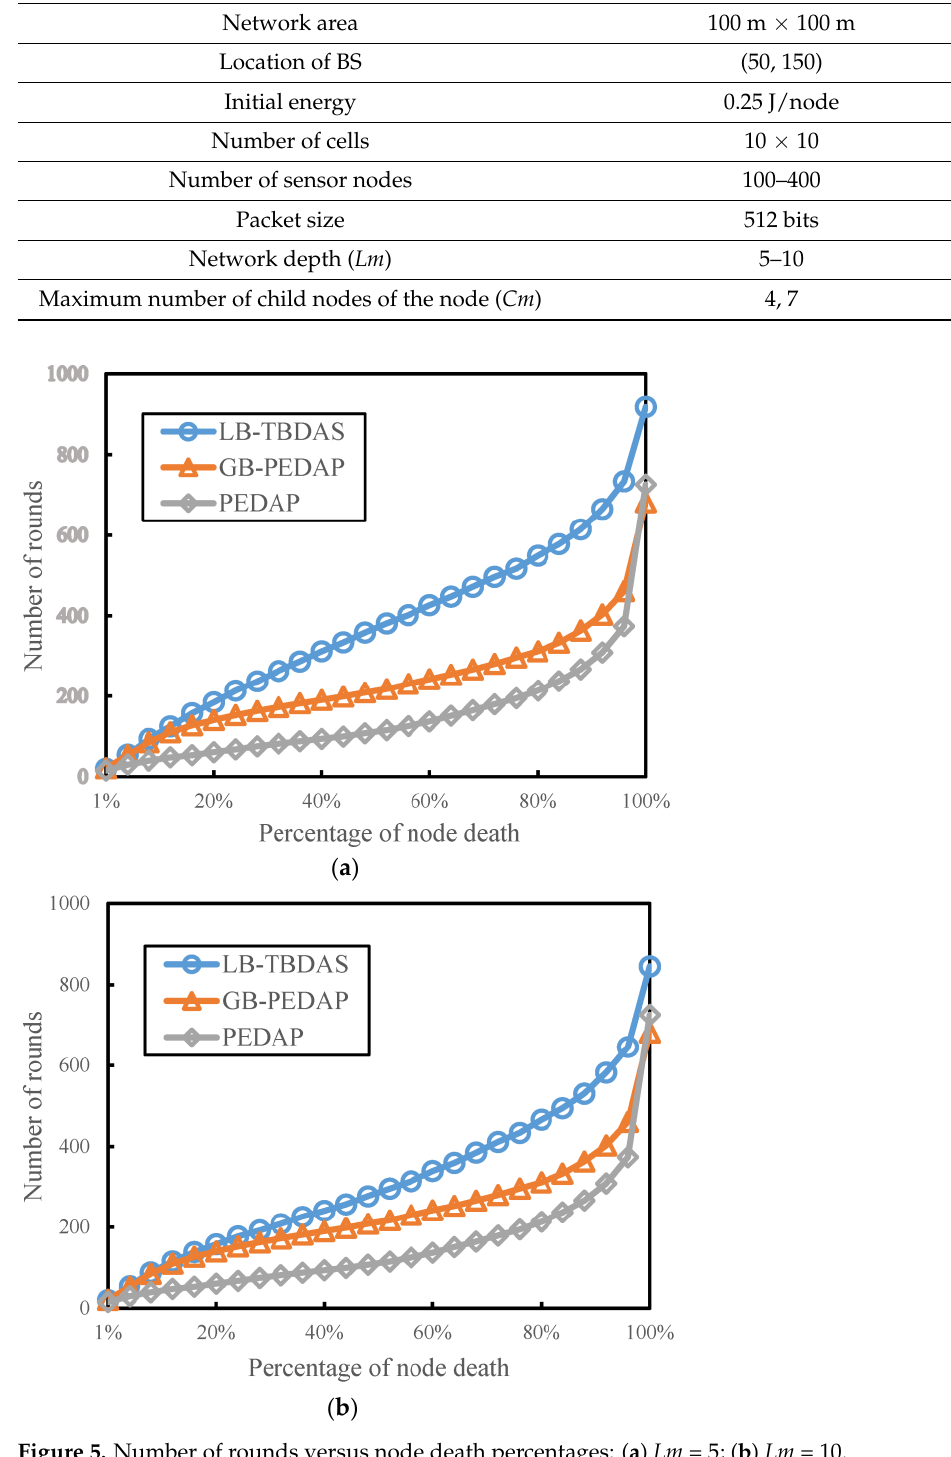
Figure 5. Number of rounds versus node death percentages: ( a ) Lm = 5; ( b ) Lm = 10.